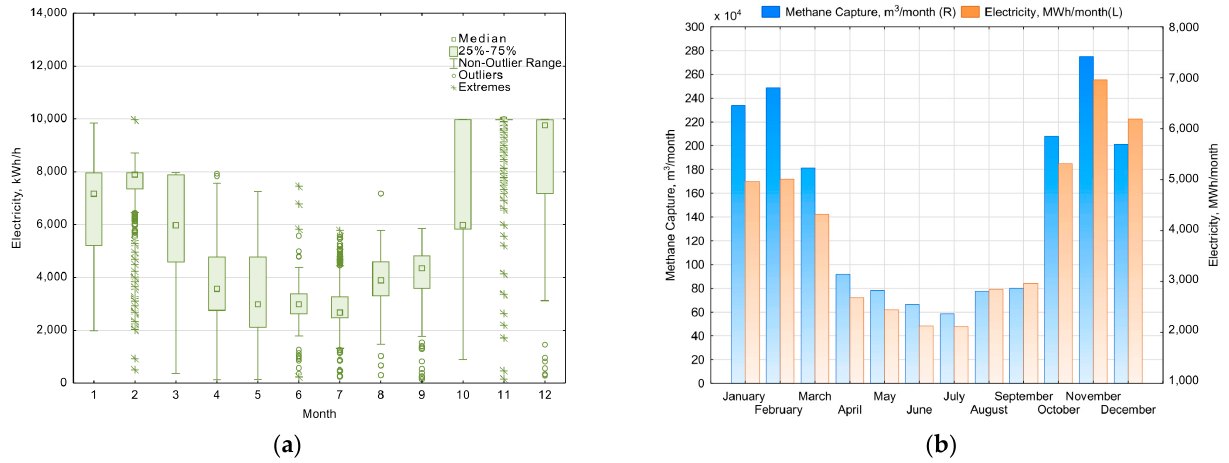
Figure 9. Variation of electricity production and methane capture by month throughout the analyzed year ( a ) box plot for electricity; ( b ) regression graph with histograms.